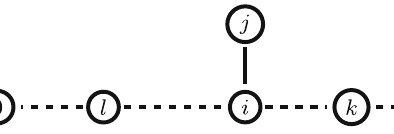
Figure 15: Minimum subgraph of C containing vertices {